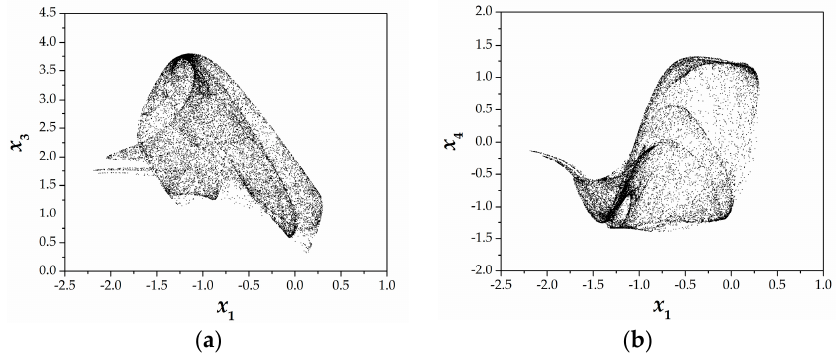
Figure 2. Poincaré maps of system (8) in ( a ) x 1 – x 3 plane and ( b ) x 1 – x 4 plane, for a = 3.8, b = 0.1 and c = 1.5 and initial conditions ( x 1 (0), x 2 (0), x 3 (0), x 4 (0)) = (0.1, 0.1, 0.1, 0.1).